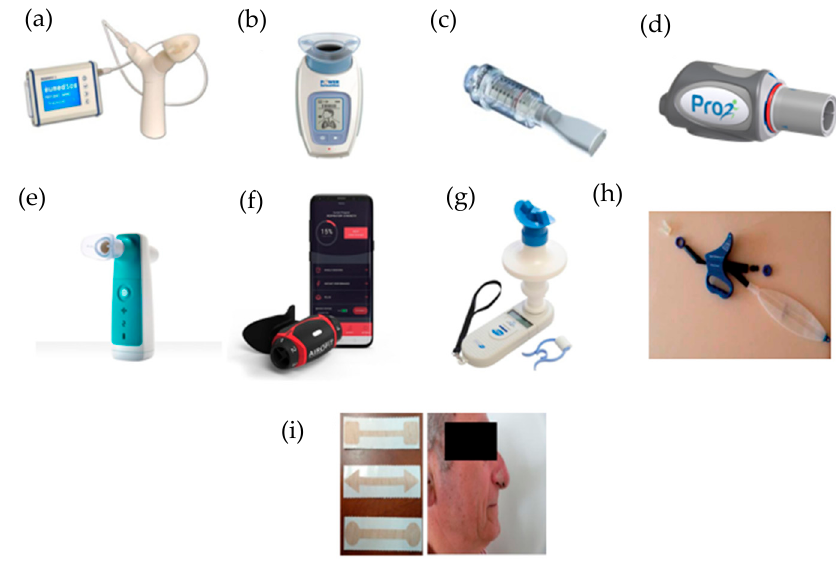
Figure 2. IMT devices used in respiratory rehabilitation. ( a ) Respifit S TM ; ( b ) PowerBreathe ® ; ( c ) Threshold IMT ® ; ( d ) PrO2Fit TM ® ; ( e ) Aerosure Medic ® ; ( f ) AeroFit IMT ® ; ( g ) MicroRPM; ( h ) SpiroTiger ® ; ( i ) FeelBreathe ®